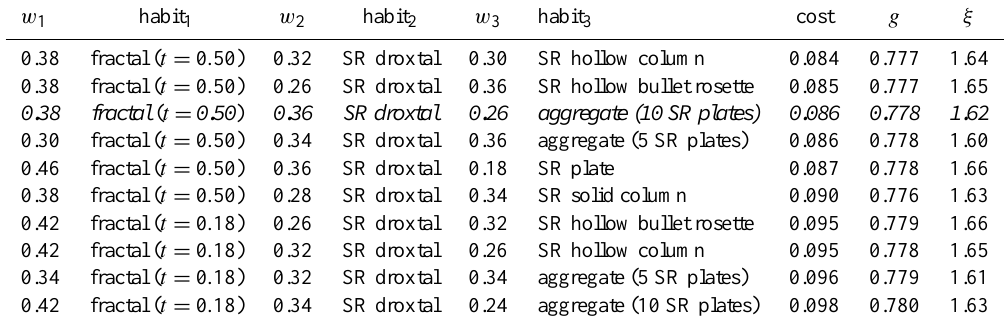
Table 1. List of best three-habit combinations. w 1 , w 2 and w 3 are the weights (i.e. fractional contributions to projected area) of each habit, “cost” is the cost function, g the asymmetry parameter and ξ a non-dimensional absorption parameter defined by Eq. (8). SR refers to severely rough particles, and t is the distortion parameter for second-generation Koch fractals. The “optimized habit combination” (OHC) is highlighted with italic font.